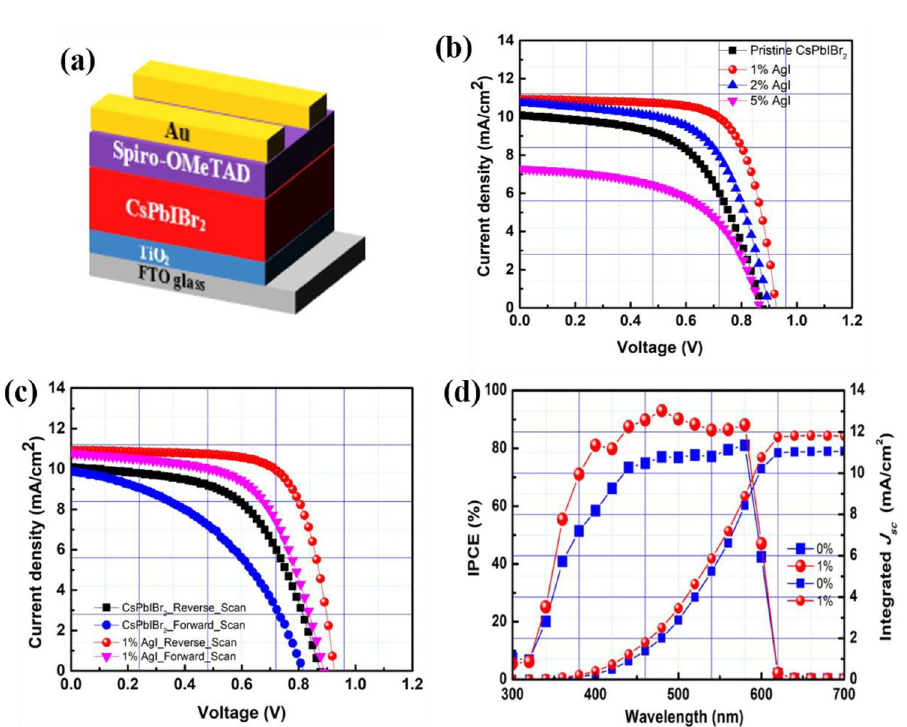
Figure 4. ( a ) Schematic diagram of the device architecture ( b ) Reserve scan of J-V curves for CsPbIBr 2 perovskite PSCs with and without AgI incorporation measured under simulated AM 1.5 G illumination ( c ) Hysteresis behavior of pristine and 1% AgI CsPbIBr 2 PSCs. ( d ) IPCE of the